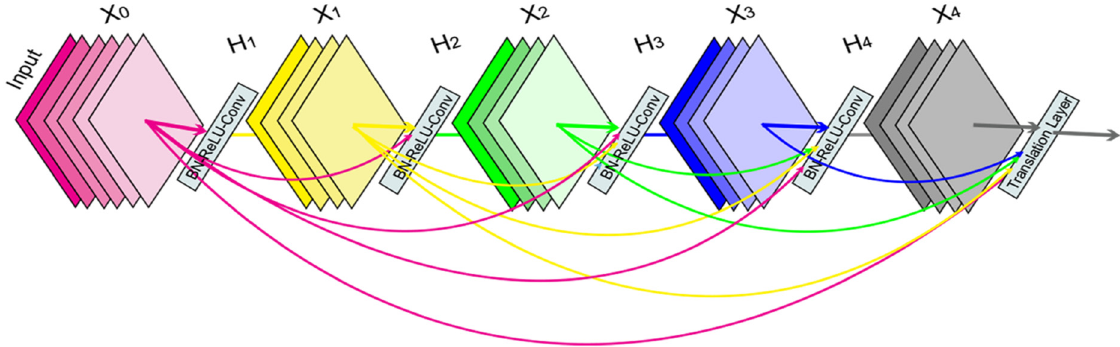
Figure 2. A dense block that illustrates that each layer takes all the previous feature maps as input.